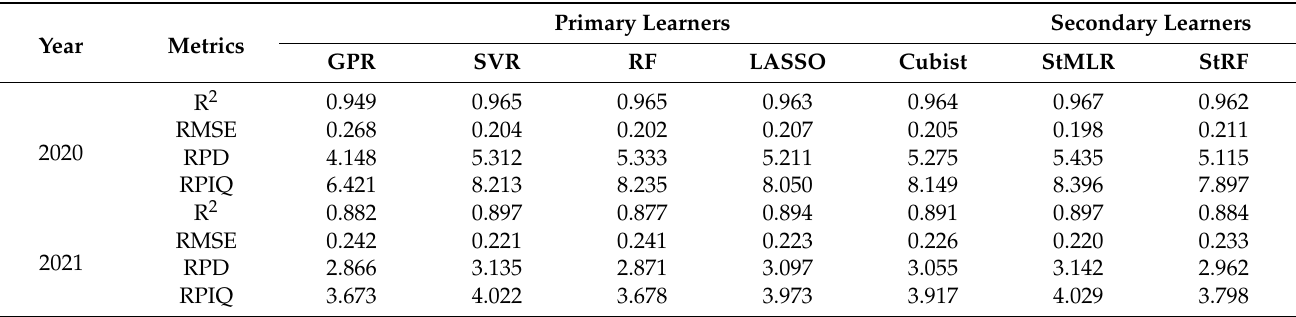
Table 8. Test set accuracy statistics of different models for LAI estimation (the accuracy parameters in this table are the average of 400 test results).